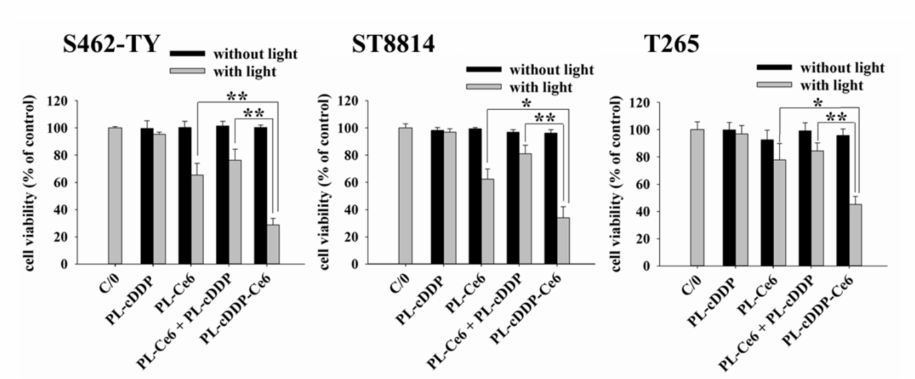
Figure 2. In vitro cytoxicity against S462-TY, ST8814, and T265 MPNST cells. Cells were incubated with di ff erent liposomal Ce6 (1 µ g / mL), cDDP (2.8 µ g / mL) or in combination for 2 h and then subjected to light irradiation (0.1 J / cm 2 ). MTT assay was used to evaluate the cell viability 24 h after light irradiation (* p < 0.05, ** p < 0.01).